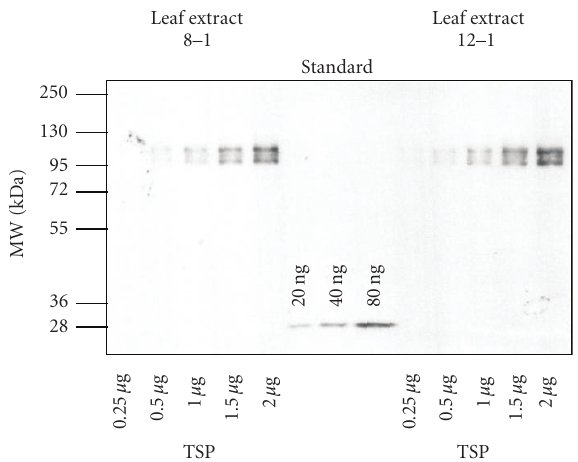
Figure 3: Quantification of TBAg-ELP in crude extracts of transgenic tobacco leaves. Dilutions of TLE-TBAg-ELP, from 2 μ g to 0.25 μ g of total soluble proteins (TSPs), were separated by reducing 10% SDS-PAGE, blotted, and immunodetected using an anti-c-myc antibody. Recombinant c-myc-tagged IL-6 was used as standard. The TBAg-ELP accumulation level was approximately 4% of TSP of crude leaf extract. Analysed leaf materials came from o ff spring plant 8 and 12 of the T 0 plant